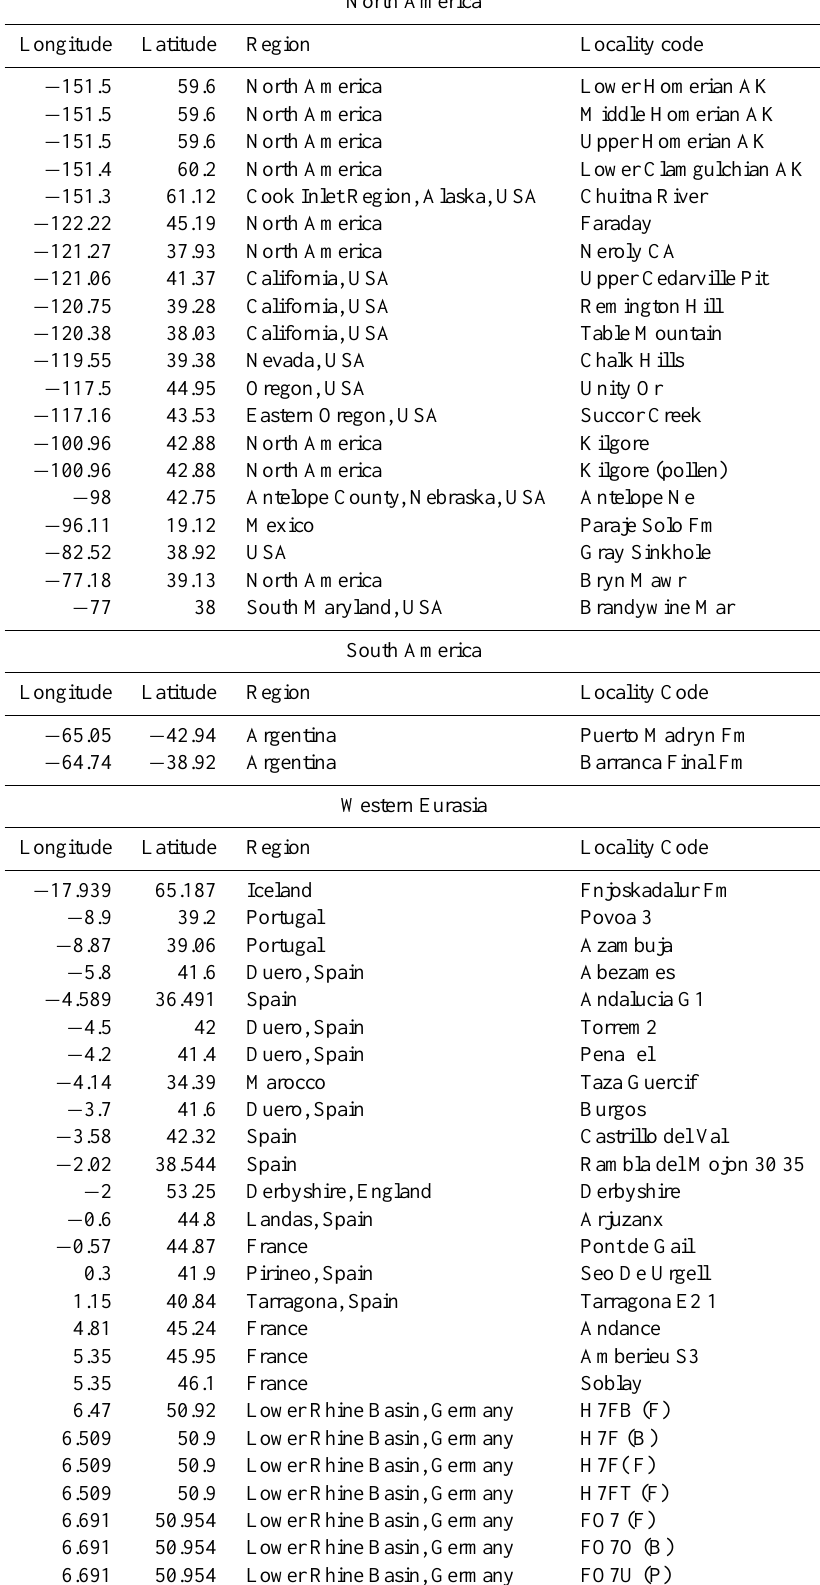
Table F1. All palaeobotanical sites used in the study.